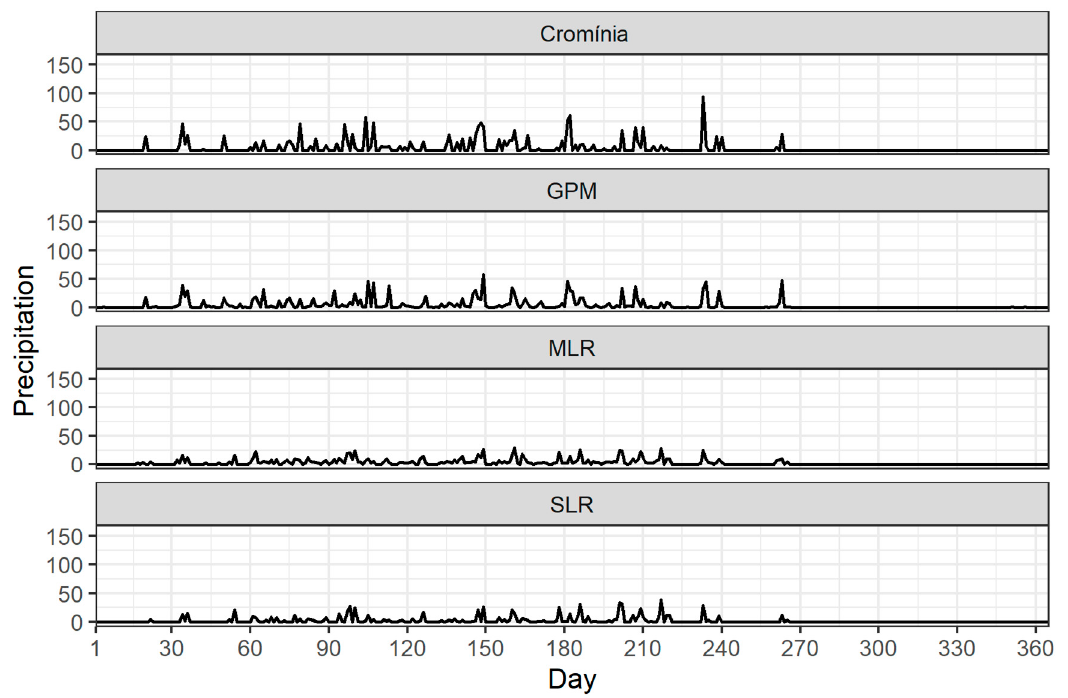
Figure 7. Direct comparison between daily precipitation estimates and observed data for the period from 1 September 2016 to 31 August 2016 at the Cromínia station. OBS, observed data; MLR, multiple linear regression method; SLR, simple linear regression; GPM, Global Precipitation Measurement method.